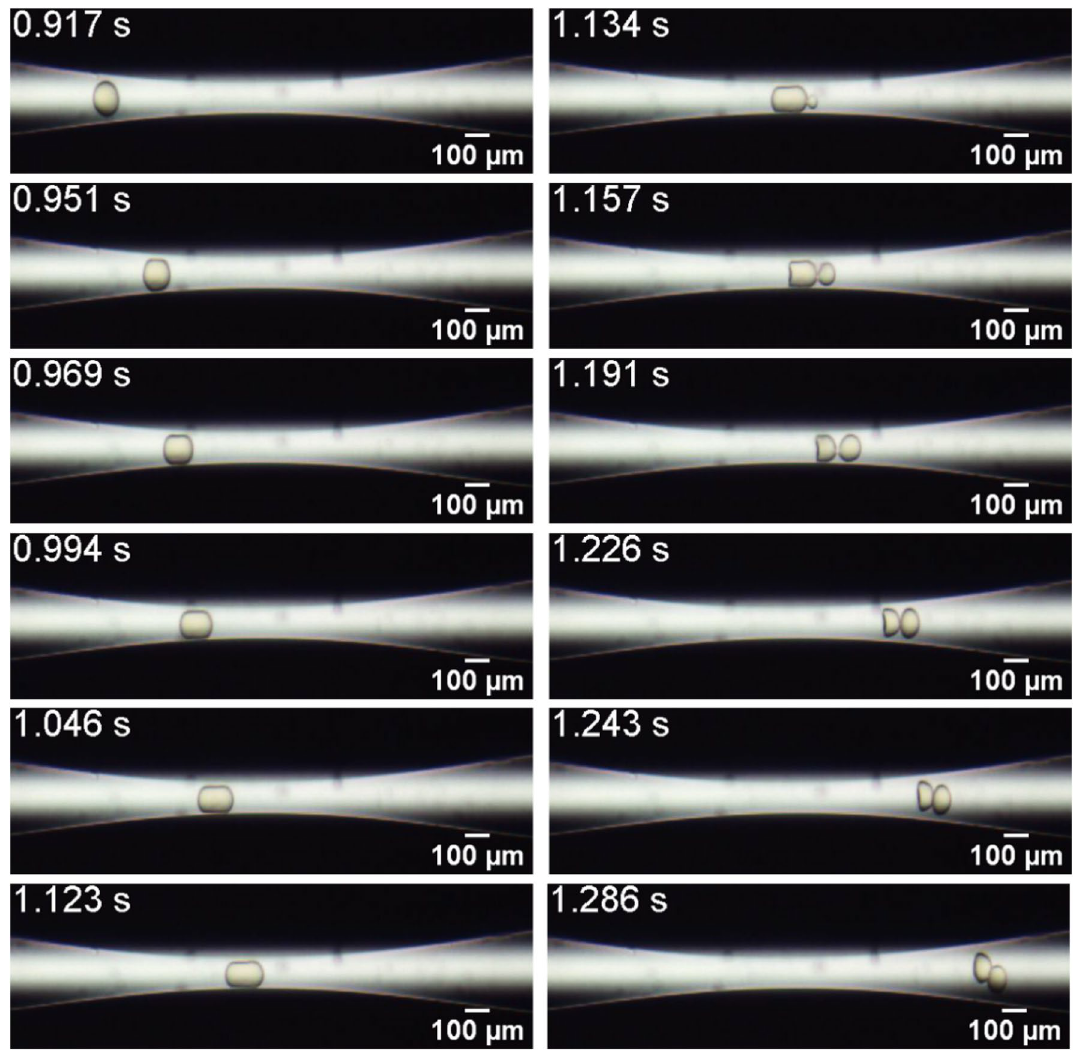
− 4 ) . The capsule ruptures and releases its inner